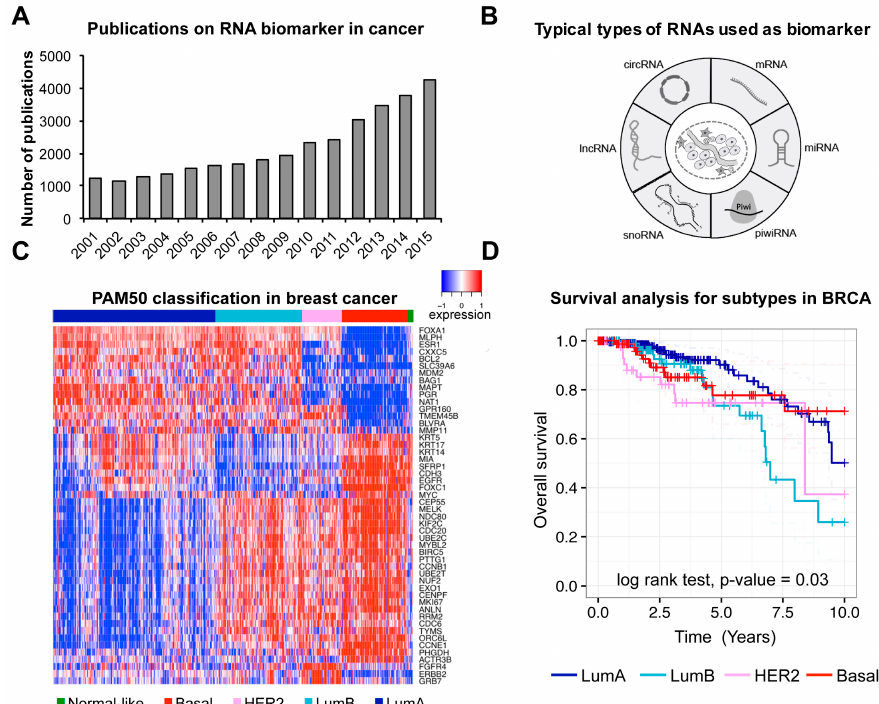
Figure 1. Studies and examples of RNA biomarkers in cancer. ( A ) Numbers of publications on RNA biomarker in cancer (The data were collected using keywords of “RNA biomarker” and “cancer” browsed in NCBI PubMed); ( B ) Typical types of RNAs used as biomarkers in cancer; ( C ) Gene expression pattern of PAM50 genes, calculated from published TCGA breast cancer data (BRCA). The patients were classified into five subtypes (Basal, HER2, LumB, LumA and Normal ‐ like) based on PAM50 genes’ expression profile; ( D ) Kaplan ‐ Meier analysis for different subtypes in the TCGA BRCA cohort. Subtypes were classified using the PAM50 panel. p ‐ value was determined based on log ‐ rank test.